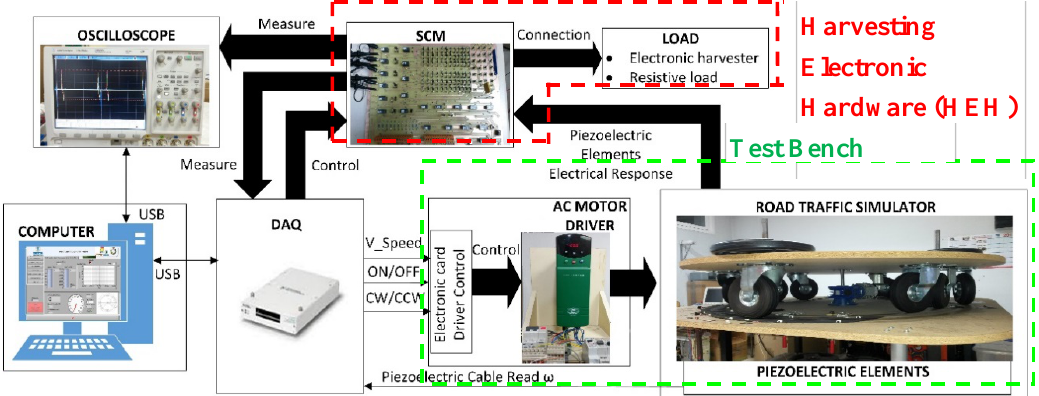
Figure 1. Piezoelectric characterization system block diagram.